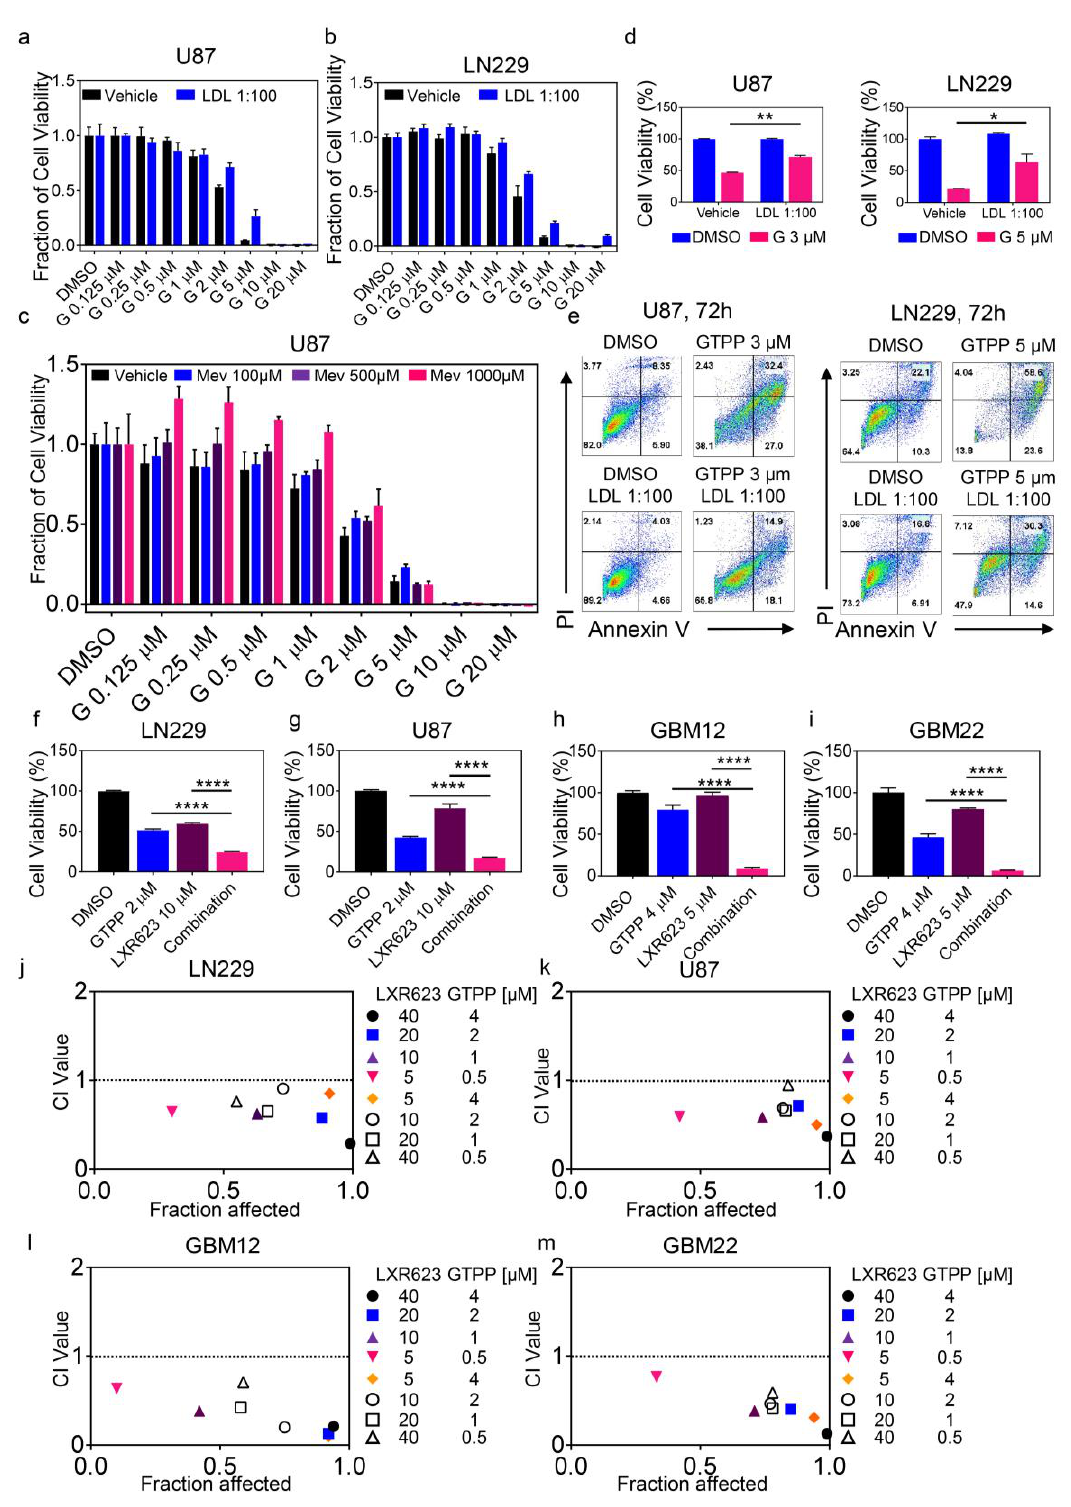
Figure 2. TRAP1 inhibition-mediated cell death is rescued by cholesterol or mevalonate and further enhanced by LXR agonists. ( a,b ) U87 and LN229 cells were treated with increasing concentration of GTPP in the presence or absence of cholesterol for 72 hours. Thereafter, cellular viability was analyzed and statistical analysis was performed. Shown are means and SD ( n ≥ 4). G: GTPP and LDL: Low Density Lipoprotein. ( c ) U87 cells were treated with increasing concentration of GTPP in the presence or absence of mevalonate (Mev) for 72 hours. Thereafter, cellular viability was analyzed and statistical analysis was performed. Shown are means and SD ( n ≥ 4). ( d,e ) U87 and LN229 cells were treated with indicated concentration of GTPP in the presence or absence of cholesterol for 72 hours.